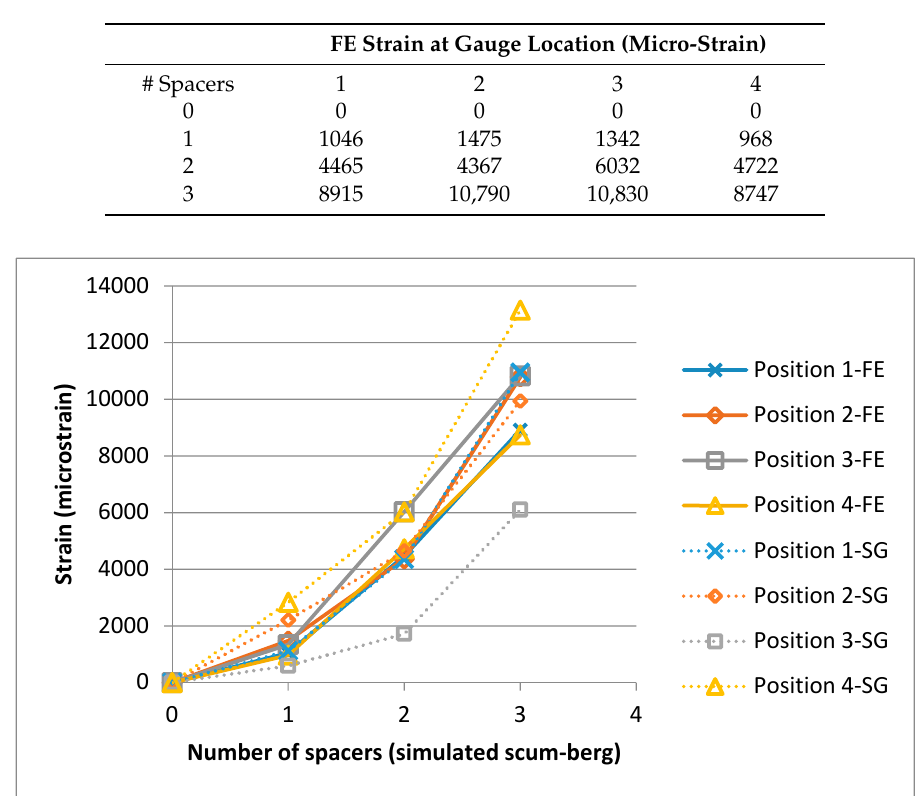
Figure 23. Strain recorded as a function of the simulated scum-berg formation beneath the membrane (FEA and strain gauge (SG)).